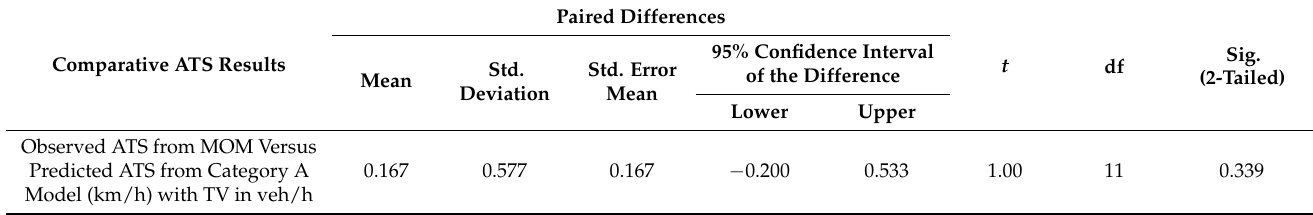
Table A5. Results of paired t -test for model of cross-sectional case of [M1, NL2,